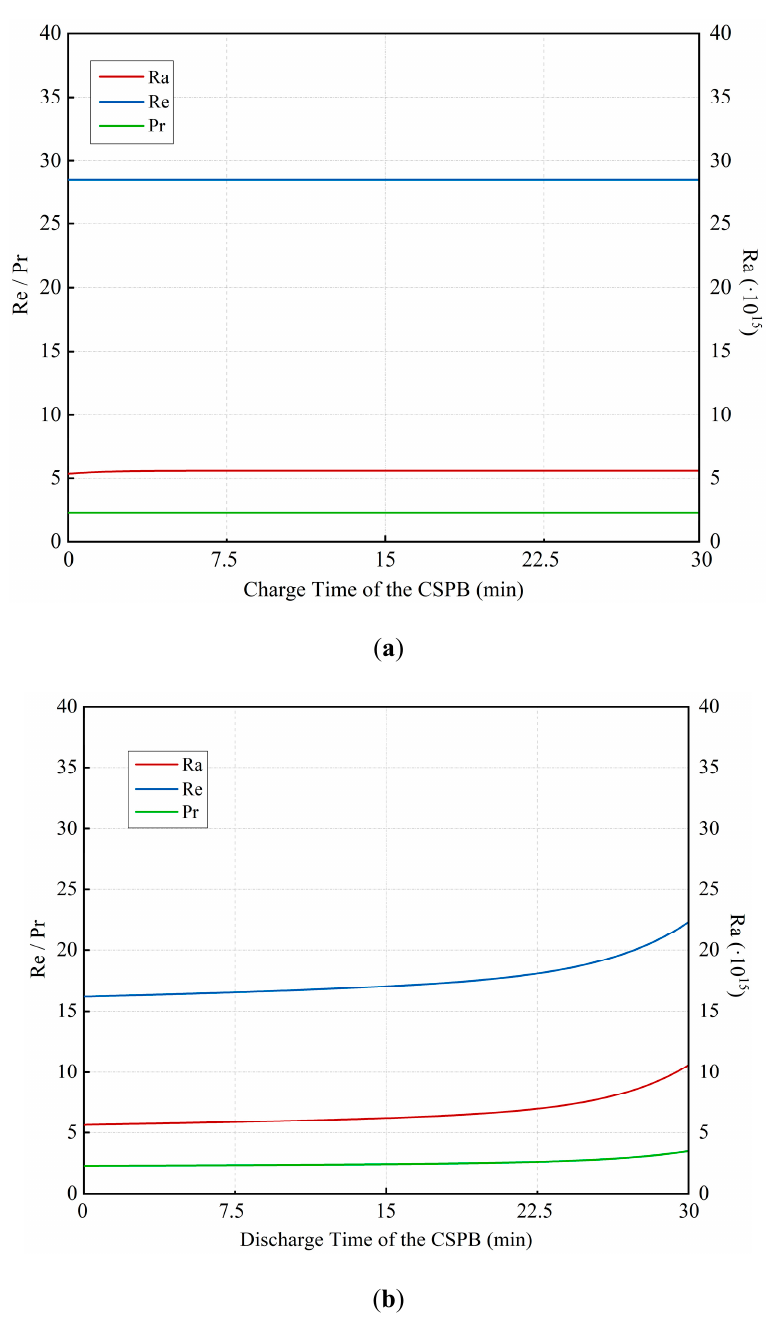
Figure 14. Operation time dependence of non-dimensional numbers at the bottom of cold storage packed bed (z = 0 m) at the ninth cycle: ( a ) charge time, ( b ) discharge time.